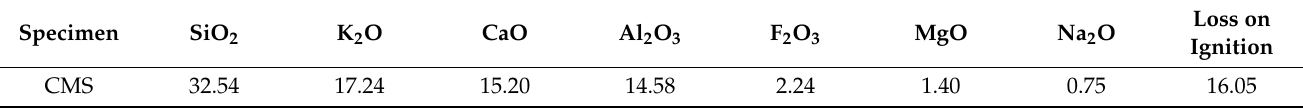
Table 2. Chemical composition of the C-M-S